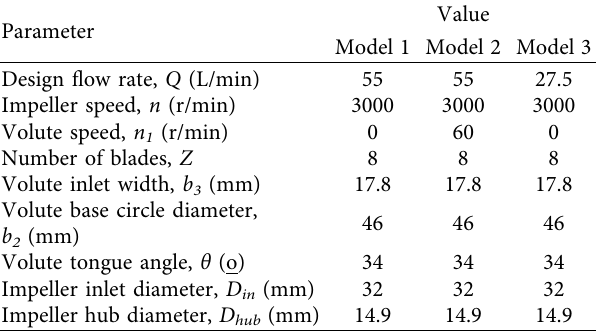
Table 1: Essential parameters of the pump. Parameter